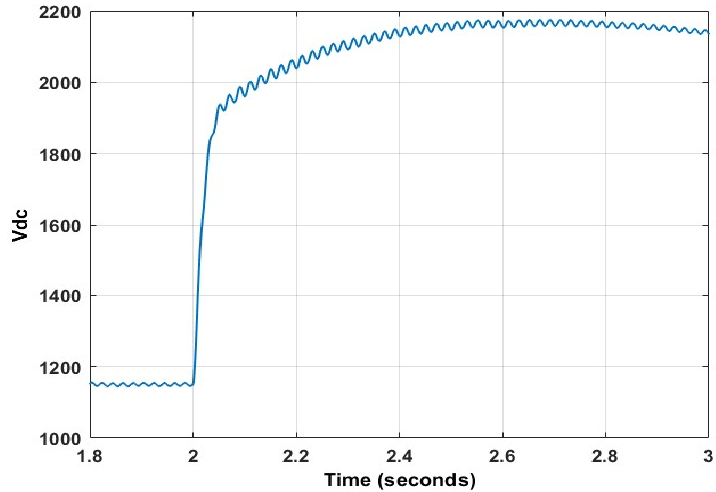
Figure 46. DC voltage transient using PI at 90% dip.